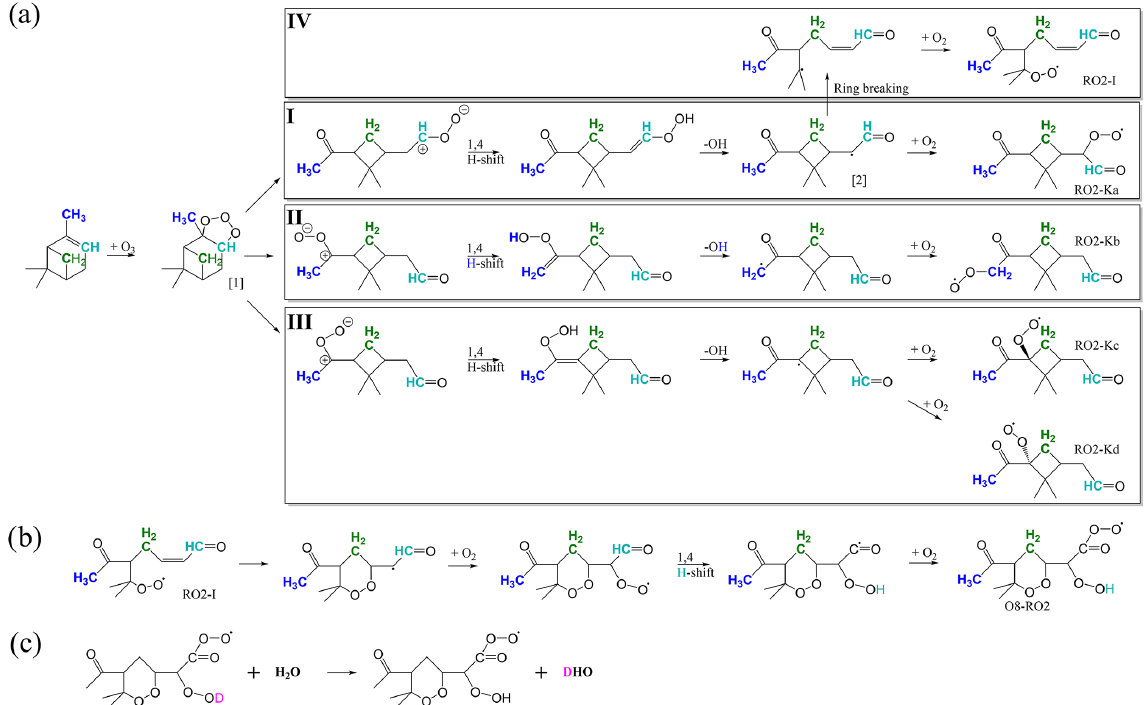
Figure 2. (a) Reaction pathways for α -pinene ozonolysis up until the primary peroxy radical (RO 2 ) from Kurtén et al. (2015) (I–III) and Iyer et al. (2021) (IV). (b) Continued reaction pathway for the IV pathway up to a peroxy radical containing eight oxygen atoms (O 8 − RO 2 ) (Iyer et al., 2021). In panels (a) and (b) the carbon and hydrogen atoms corresponding to deuterated ones in the selectively deuterated precursors are coloured matching the colouring in Fig. 1; i.e. cyan corresponds to the 3 D 1 precursor, green corresponds to the 7 D 2 precursor, and blue corresponds to the 10 D 3 precursor. (c) Deuterium atoms are readily exchanged between HOMs and water vapour if the deuterium is in an − OD or − OOD group, resulting in HOMs without deuterium and semi-heavy water, i.e. a water molecule with one hydrogen atom and one deuterium atom instead of two hydrogen atoms (Rissanen et al.,